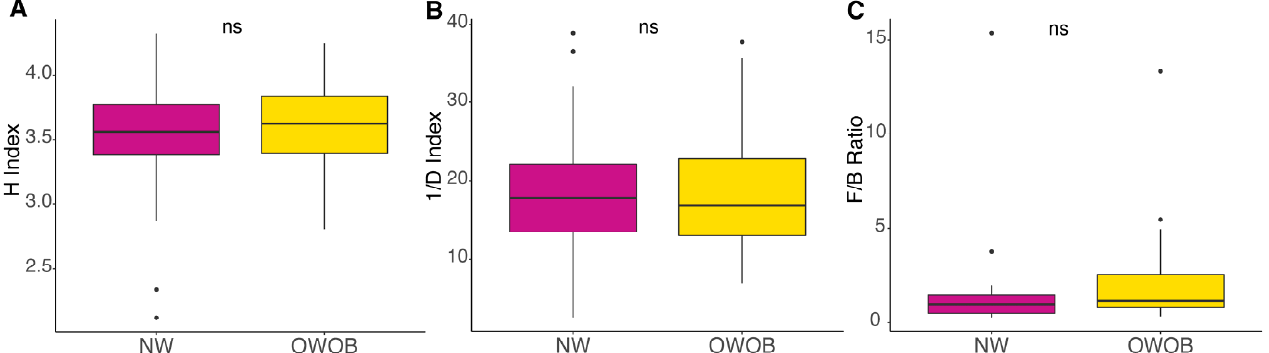
Figure 1. Phylum relative abundance of the 46 samples included in this study ordered by BMI.